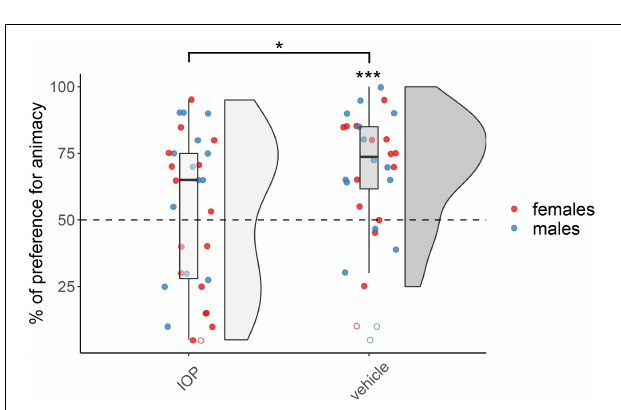
FIGURE 2 | Preference for animacy for the chicks tested 1 day after hatching injected with IOP or with vehicle. To best represent the data, we used raincloud plots. Asterisks indicate significant differences from chance (black dotted line). Black asterisk between the two groups indicates a significant difference between IOP- and vehicle-injected chicks. *** indicates p < 0.001, * indicates p < 0.05. Filled red dots represent female and blue male subjects, empty dots represent outliers, which were removed from the analyses.